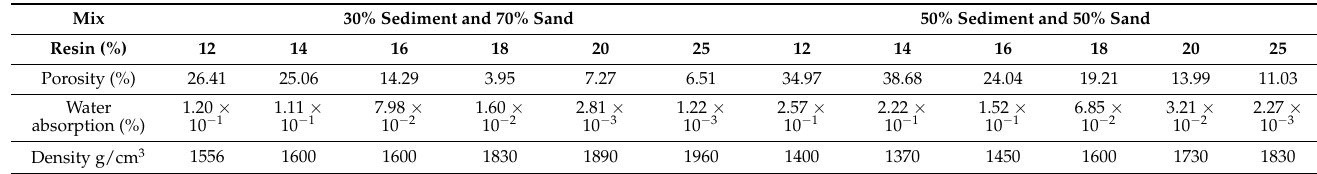
Table 4. Main mechanical and physical